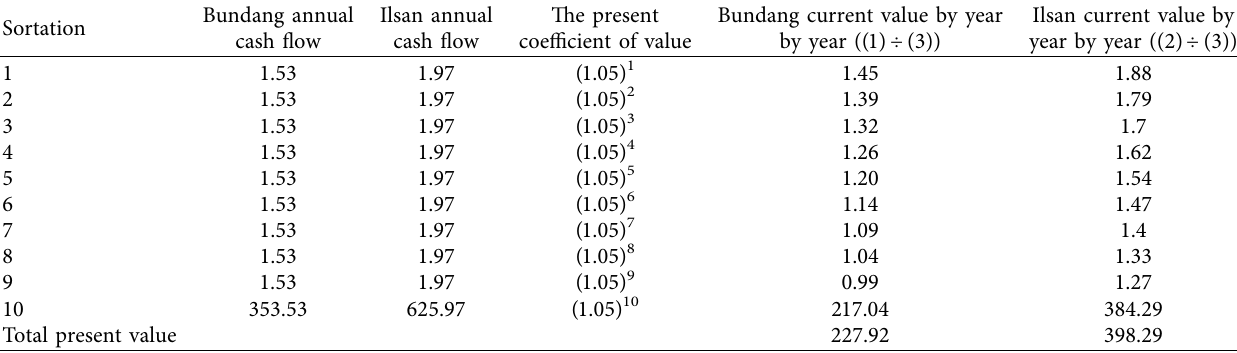
Table 3: Estimation of the present value of the public sports centers in Bundang and Ilsan (unit: KRW 100 million).